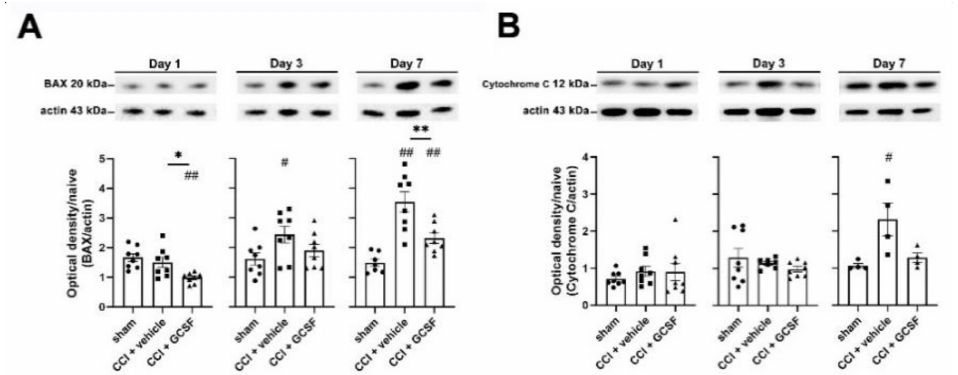
Figure 5. G-CSF downregulated BAX protein levels and cytochrome c (apoptosis) in the injured sciatic nerve on the 7th day after nerve injury. Statistical analyses of those proteins (BAX, cytochrome c) were analyzed by the data from micro-Western array in the NHRI; then, we verified the protein expressions by the traditional representative Western blot bands in our laboratory. ( A ) Western blot analysis revealed significantly lower BAX levels in the injured sciatic nerve in G-CSF-treated CCI rats than in vehicle-treated CCI rats and sham control rats (* p < 0.05: G-CSF-treated CCI rats compared to vehicle-treated CCI rats; ## p < 0.01: G-CSF-treated CCI rats compared to sham control rats) on the 1st day after nerve injury. However, there was no significant difference between vehicle-treated CCI rats and sham control rats. In contrast, western blot analysis revealed significantly higher BAX levels in the injured sciatic nerve in vehicle-treated CCI rats than in sham control rats ( ## p < 0.01, # p < 0.05: vehicle-treated and G-CSF-treated CCI rats compared to sham control rats) on the 3rd and 7th days after nerve injury. Significantly lower BAX levels were observed in the injured sciatic nerve in G-CSF-treated CCI rats than in vehicle-treated CCI rats on the 7th day after nerve injury (** p < 0.01: G-CSF-treated CCI rats compared to vehicle-treated CCI rats). The data are shown as the means ± SEM. n = 8 for each group. ( B ) On the 7th day after nerve injury, there were higher cytochrome c levels in the injured nerve in vehicle-treated CCI rats than in sham control rats ( # p < 0.05: vehicle-treated and G-CSF-treated CCI rats compared to sham control rats). However, there were no significant differences between the vehicle-treated group and the G-CSF-treated group. The data are shown as the means ± SEM. n = 8 for each